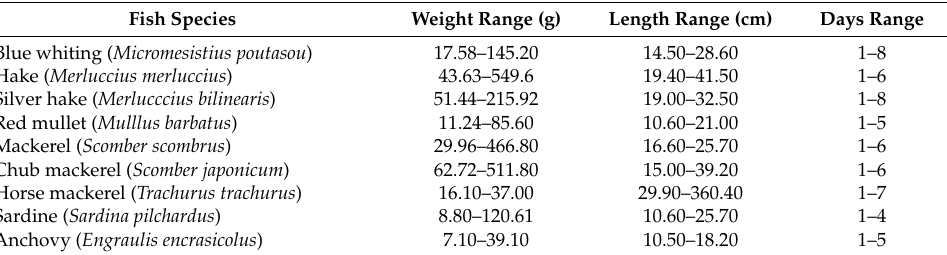
Table 6. Weight, length and days passed between capture and analysis of the